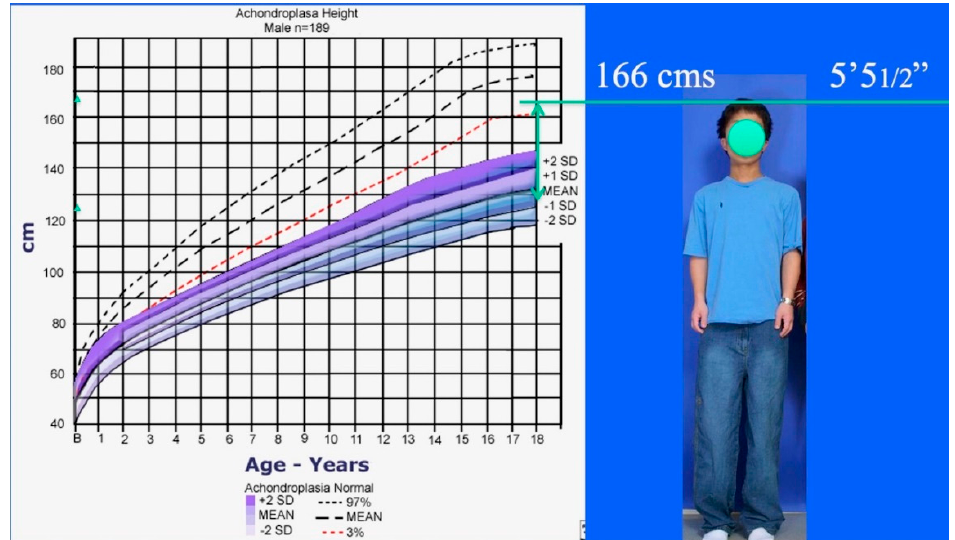
Figure 3. Achondroplastic male height growth chart (lower shaded) compared to normal male height growth chart (upper dashed). Achrondroplastic boy from Figure 1 standing to right of growth chart showing his 15.75 ″ = 40 cm lengthening added to his preoperative predicted height at maturity (120 cm). Final adult height after three 4-segment lower limb lengthenings is 5 ′ 5.5 ″ = 166.3 cm which is in the normal height range for an adult male.